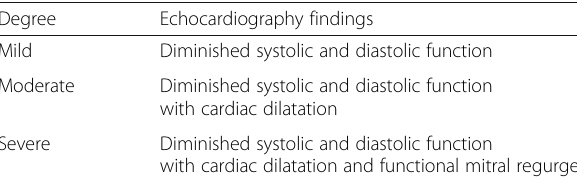
Table 1 Echocardiography severity according to our